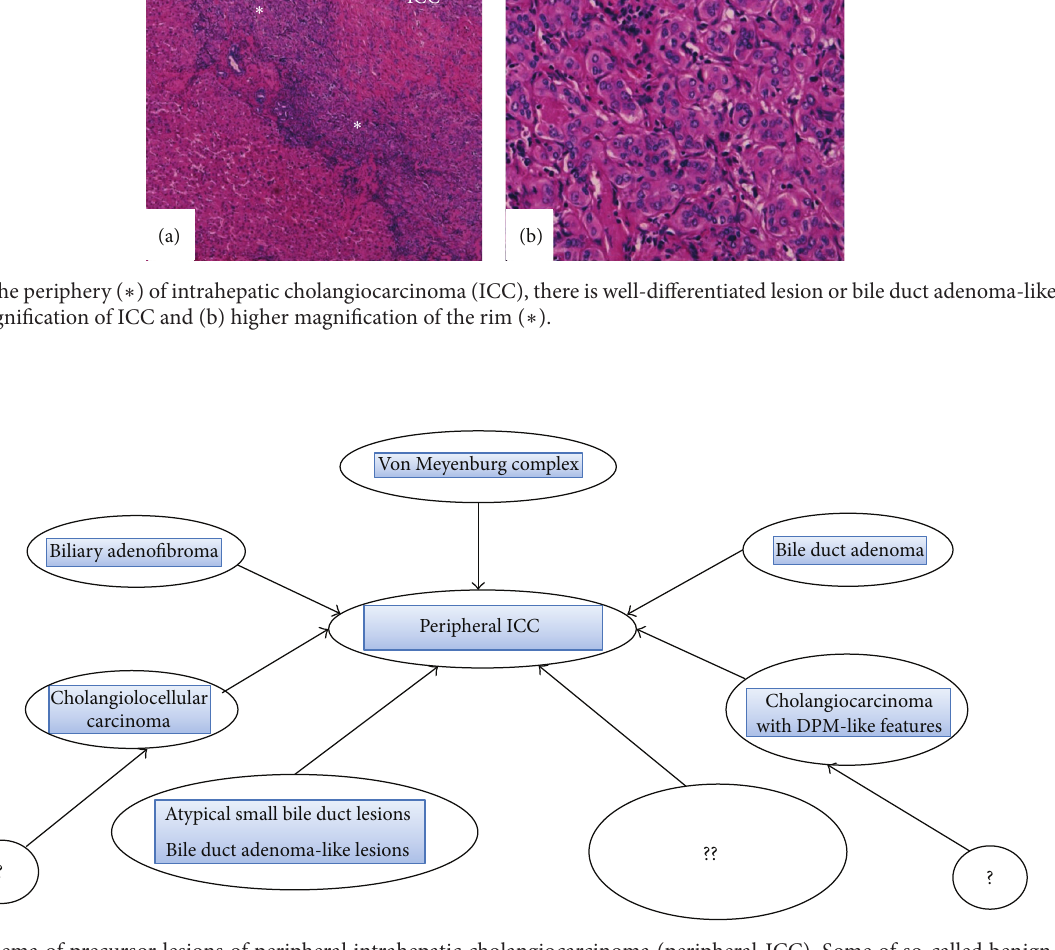
Figure 8: Schema of precursor lesions of peripheral intrahepatic cholangiocarcinoma (peripheral-ICC). Some of so-called benign lesions such as bile duct adenoma, von Meyenburg complex, and biliary adenofibroma are occasionally followed by the development of peripheral- ICC, and some of low grade cholangiocarcinoma (cholangiolocellular carcinoma and cholangiocarcinoma with ductal plate malformation (DPM)-like features) are also followed by ordinary peripheral-ICC. In addition, bile duct adenoma-like lesion and atypical small bile duct lesions described here could be also related to the development of peripheral ICC. Unidentified factors or lesions and may also be involved in the development of peripheral